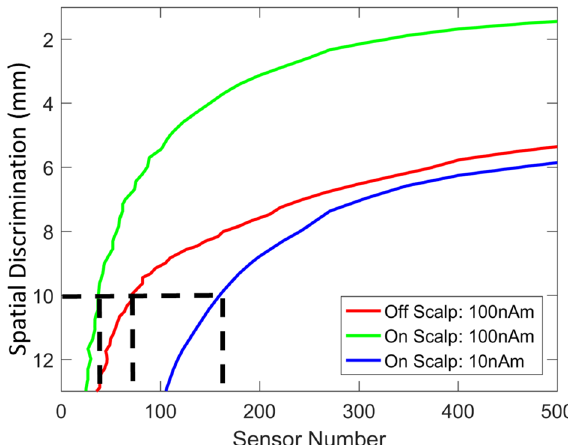
Figure 5. Sensor number and spatial discrimination for on- and off-scalp systems. Sensor number (x-axis) is graphed against spatial discrimination (y-axis) for both on-scalp (green, blue) and off-scalp (red) systems at different signal levels (100 nAm, 10nAm). Neither system had discrimination performance below 12 mm at 1 nAm and the off-scalp system did not reach this level at 10 nAm and so these curves are not shown (results are averaged across brain regions). While both systems are capable of achieving spatial discrimination of sources better than 1 cm across the whole brain (black dotted lines), the on-scalp system (blue and green curves) can achieve this with considerably fewer channels. Importantly, one can see for a given spatial discrimination an on-scalp system requires fewer sensors than an off-scalp system for a given signal level. The sensor to scalp distances for on and off-scalp systems are 6.5 and 20 mm